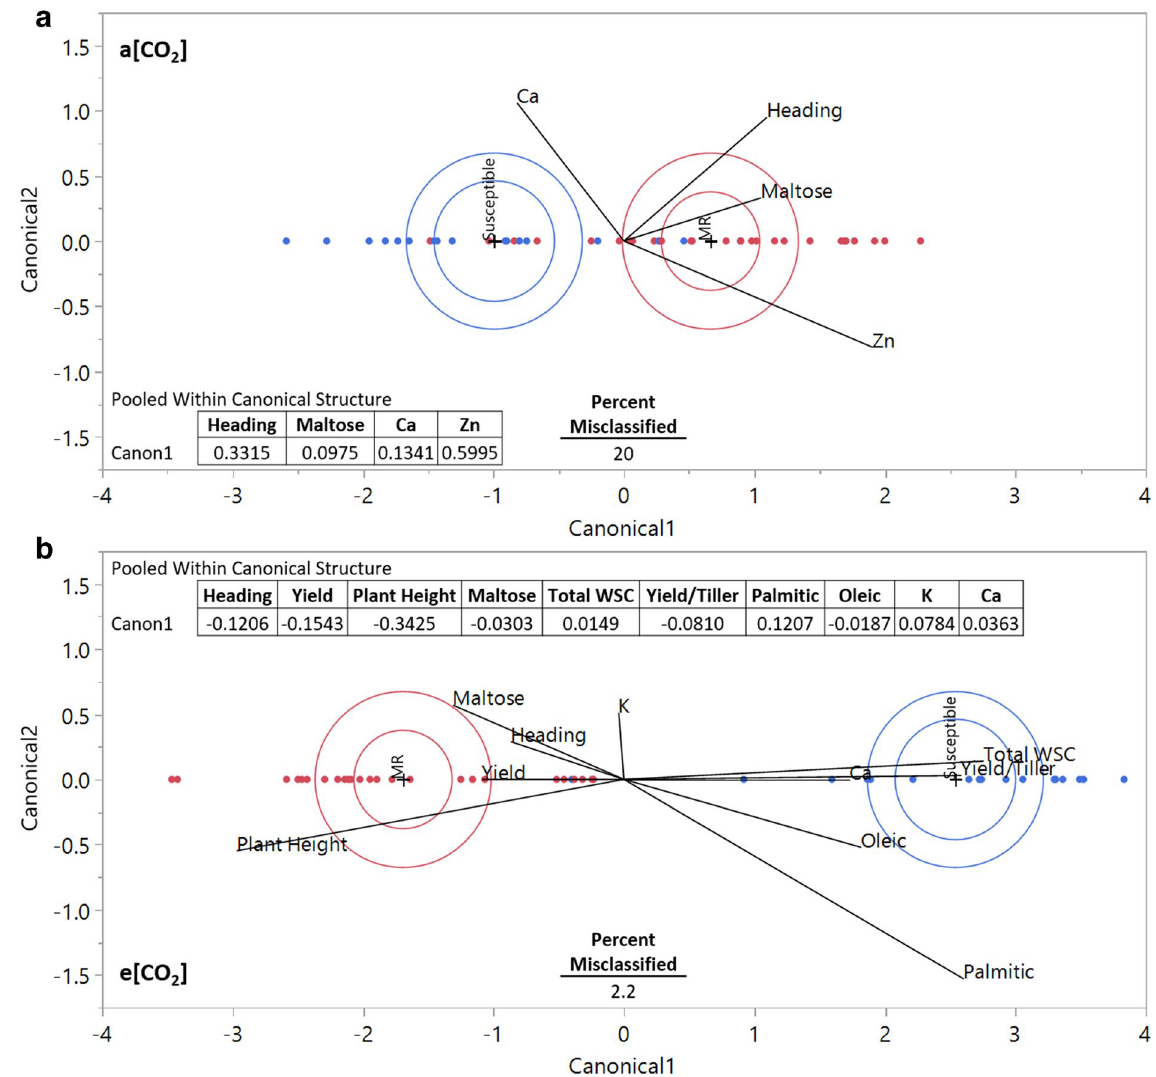
Figure 7. Discriminant analysis applied to the Fusarium head blight (FHB) susceptible and moderately resistant (MR) cultivars at ( a ) ambient CO 2 (a[CO 2 ]), and ( b ) elevated CO 2 (e[CO 2 ]). Groups are separated along Cannonical1 by the function coefficients of the independent variables presented in each table, found within the figure panel ( a,b) . Blue objects represent susceptible cultivars, red MR. The inner circle represents the 95% confidence region of the group mean, and the outer circle represents the area containing 50% of the group population. Rays represent the independent variables relative association with the canonical variable along the Canonical1